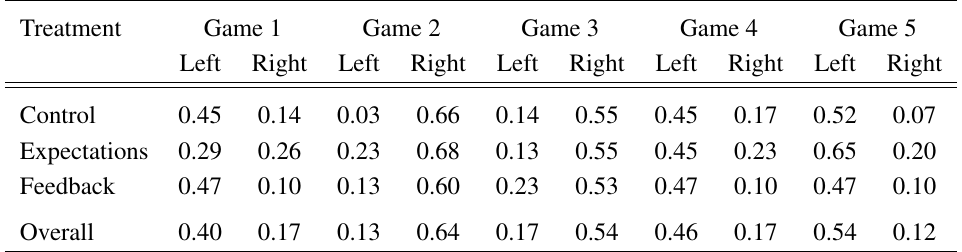
Table 6. Disapproval rates of the recipient in the five dictator games (costless messages) for all three PD treatments.